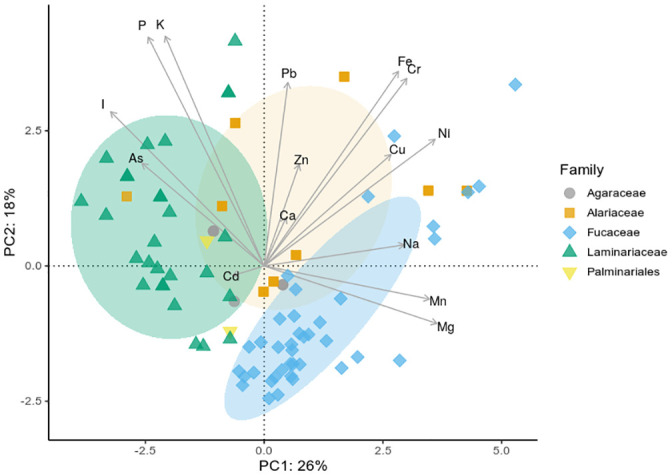
Principal component analysis of element content on family level of Greenland seaweeds.Agaraceae (A. clathratum), Alariaceae (A. esculenta), Fucaceae (A. nodosum, F. distichus, F. vesiculosus and Fucus spp.), Laminariaceae (H. nigripes, L. solidungula, S. latissima and S. longicruris) and Palminariales (P. palmata). Hg and Se were excluded from the analysis due to the low number of quantifiable samples. Ellipses denote 95% confidence intervals for Alariaceae, Fucaceae and Laminariaceae.